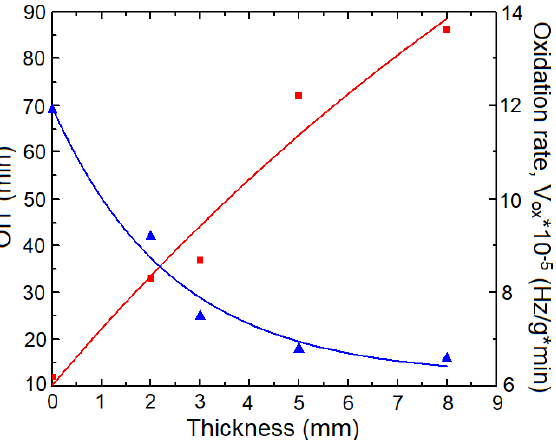
Figure 13. Oxidation induction time and oxidation rate vs. depth in PE-insulating material (isother- mal CL, 200 °C, air).